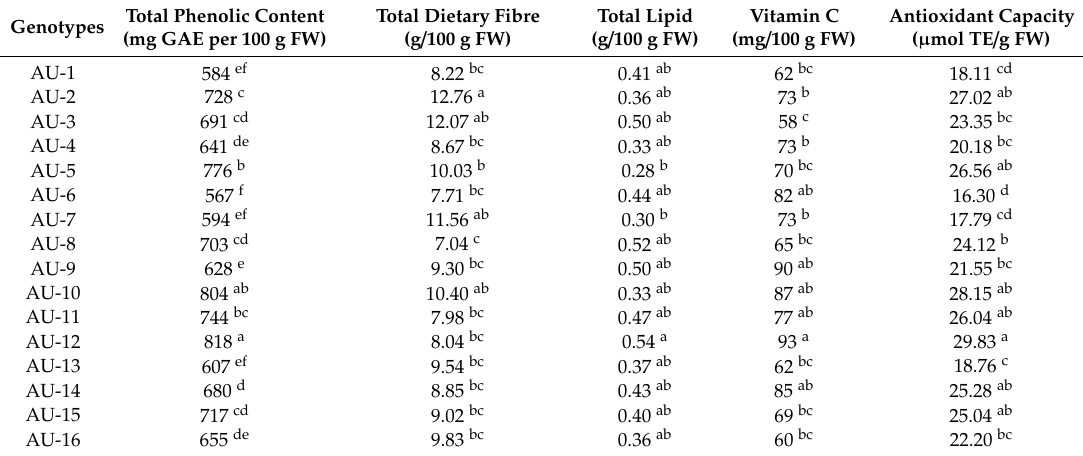
Table 5. Total phenolic, total dietary fiber, total lipid, antioxidant capacity, and vitamin C content in the fruit of strawberry tree genotypes (average of 2017–2018